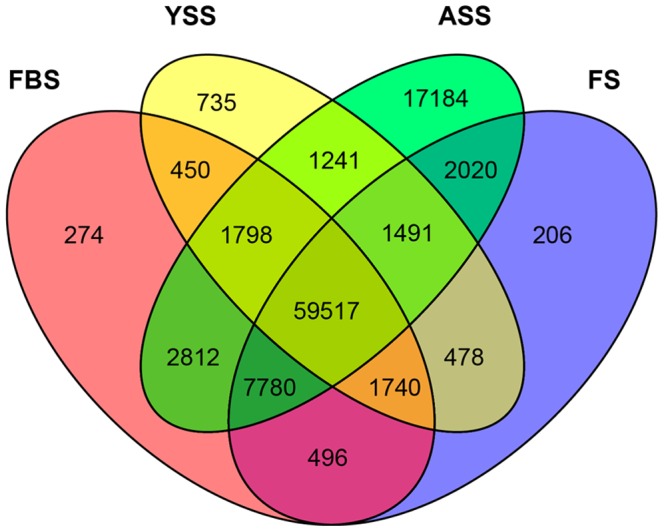
Venn diagram showing shared and unique unigenes from four developmental stages of Am. tricolor in vitro plantlet growth and flowering.